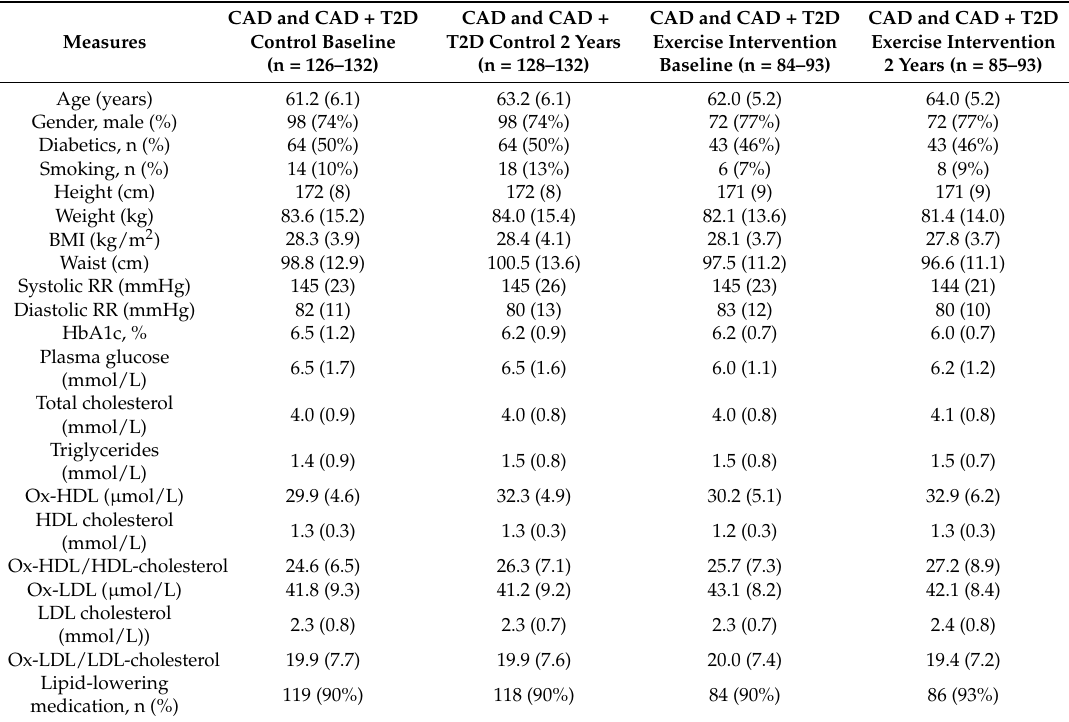
Table 1. Clinical characteristics of the